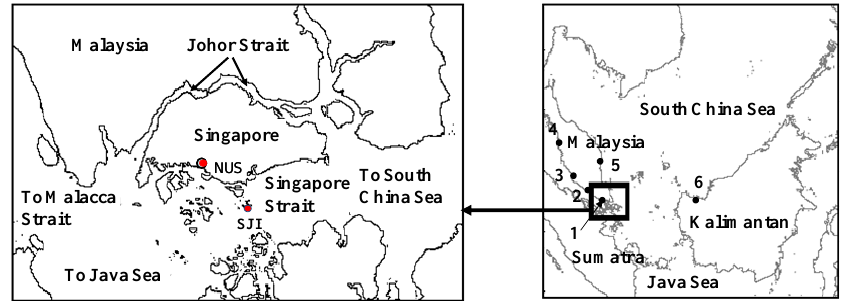
Fig. 2. Map showing sampling locations in Singapore and surrounding regions. Note: 1. Johor Bahru, 2. Malacca Town, 3. Kuala Lumpur, 4. George Town, 5. Kuantan and 6.